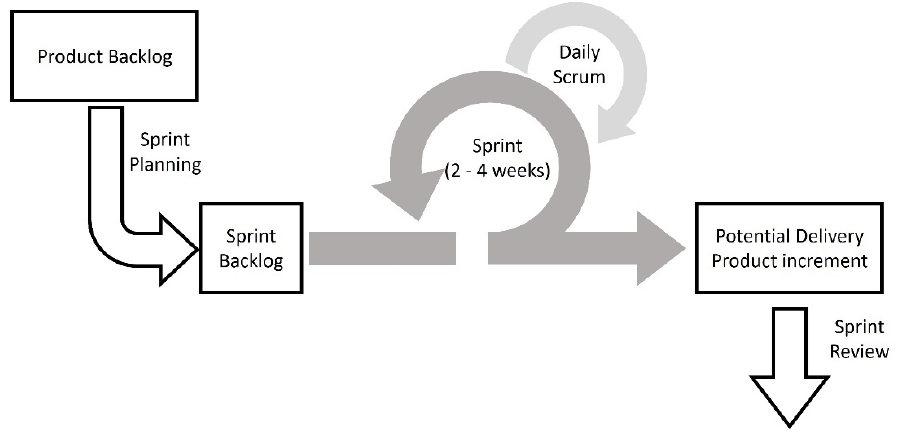
Figure 2. Scrum development cycle—part of Agile methodologies.